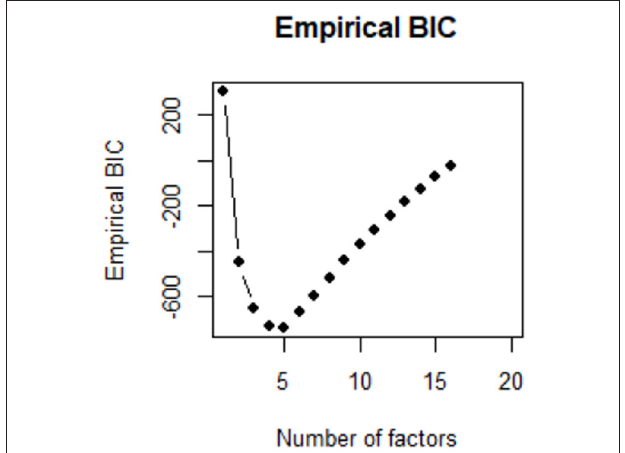
FIGURE 2 | Measure for the number of